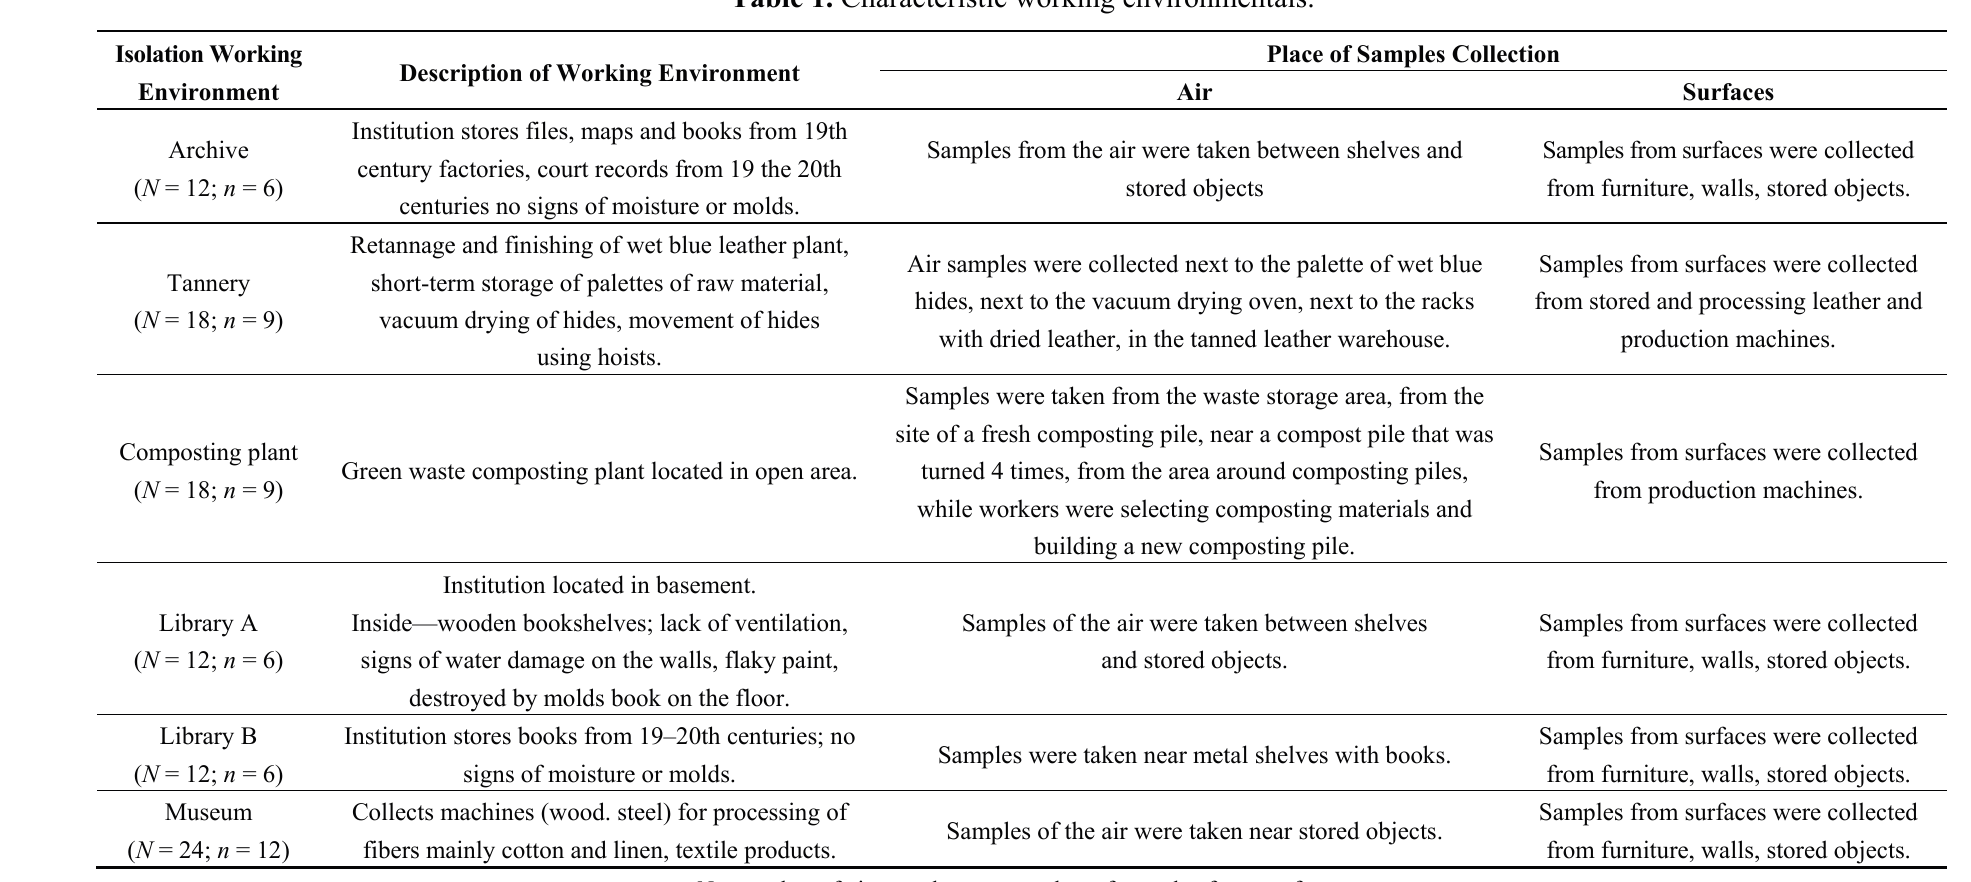
Table 1. Characteristic working